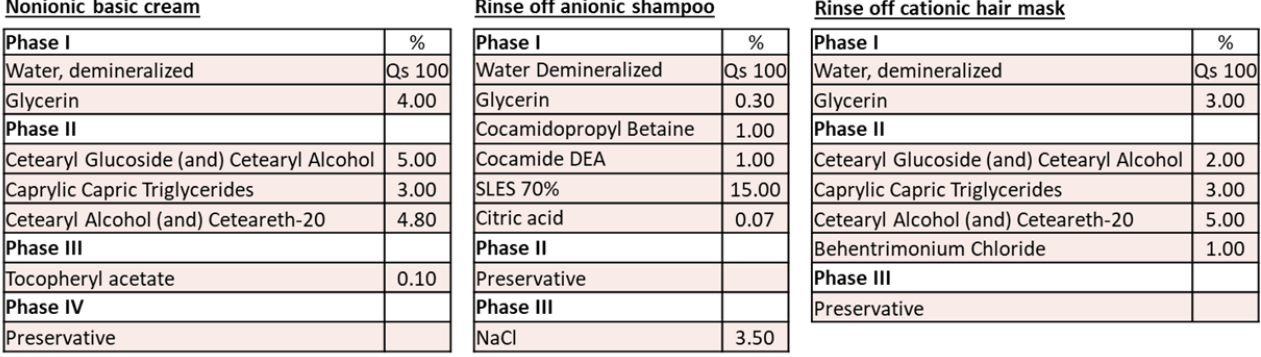
Figure 2. Formulations of three different cosmetic products that were used for challenge tests. From left to right: nonionic basic cream, rinse-off anionic shampoo and rinse-off cationic mask.